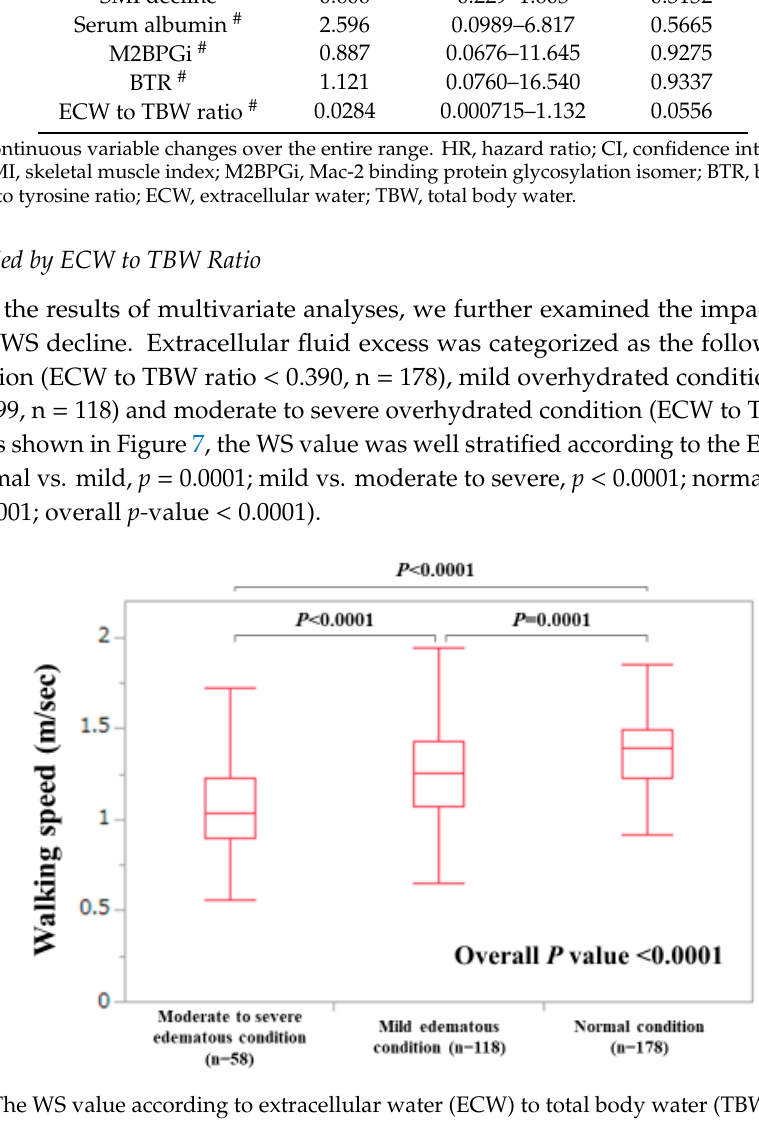
Figure 7. The WS value according to extracellular water (ECW) to total body water (TBW) as assessed by bioimpedance analysis. Normal condition indicates an ECW to TBW ratio < 0.390 (n = 178), mild overhydrated condition indicates an ECW to TBW ratio 0.390–0.399 (n = 118) and moderate to severe overhydrated condition indicates an ECW to TBW ratio ≥ 0.400 (n = 58). Missing data for the ECW to TBW ratio, n = 2.